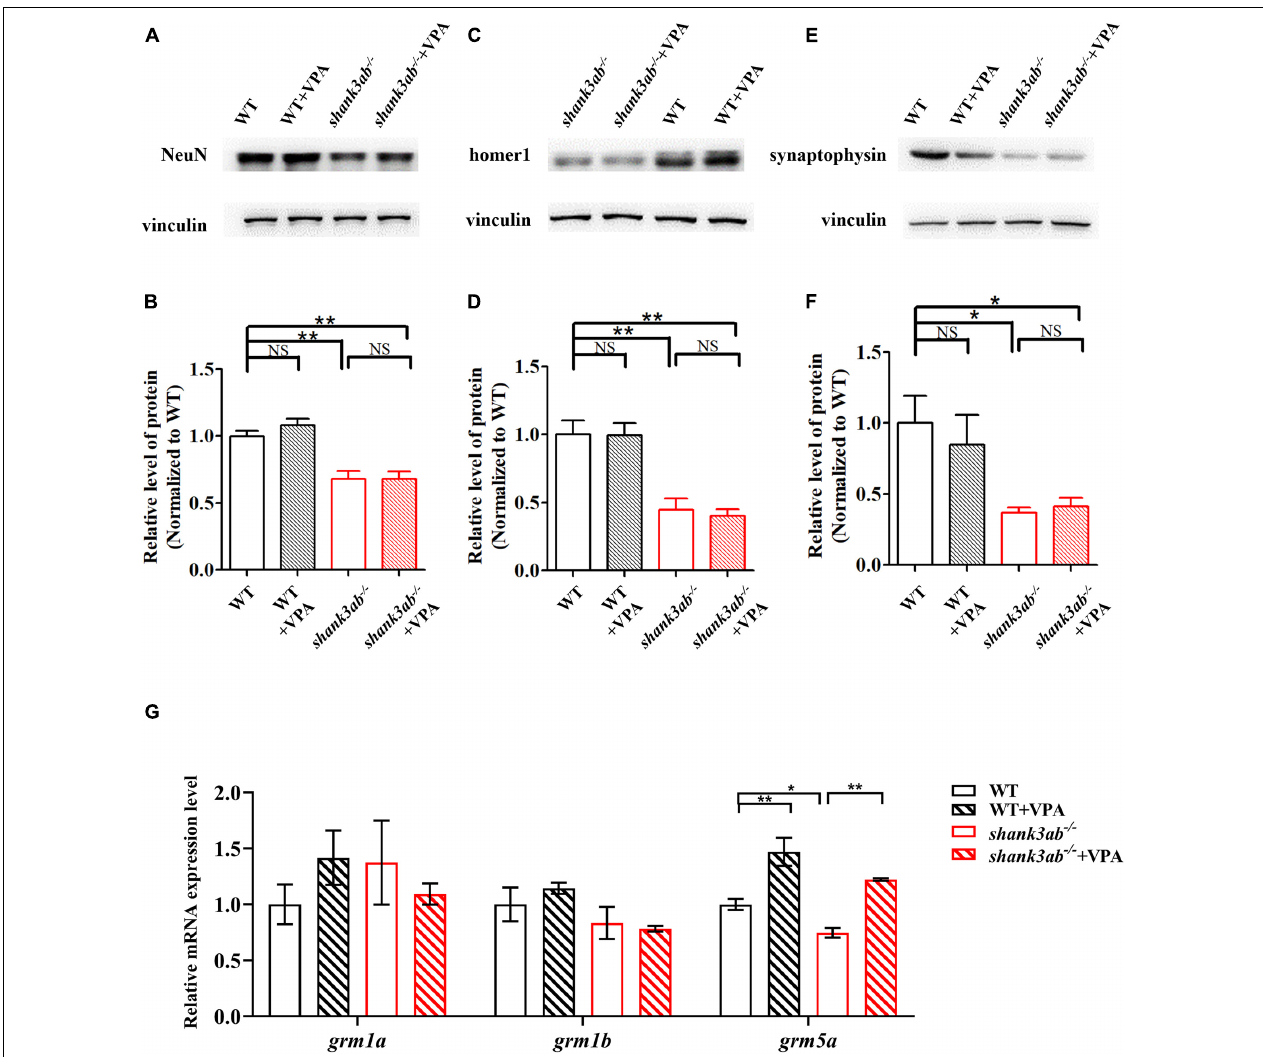
FIGURE 6 | Increased grm5 expression level in shank3 -deficient zebrafish upon early VPA treatment. (A,B) Quantitative immunoblot blot analysis showed that the expression level of neuron protein NeuN was not significantly restored in the brain of s hank3ab - / - zebrafish treated with VPA relative to WT zebrafish (2 mpf). Similarly, the expressions of post-synaptic homer1 protein (C,D) and presynaptic synaptophysin protein (E,F) were not significantly increased in in the brain of s hank3ab - / - zebrafish treated with VPA relative to WT zebrafish (2 mpf). (G) The relative mRNA expression levels of grm1a , grm1b , and grm5a at 4.5 mpf were detected. Each group n = 3. Data are shown as mean ± SEM. * P < 0.05, ** P <